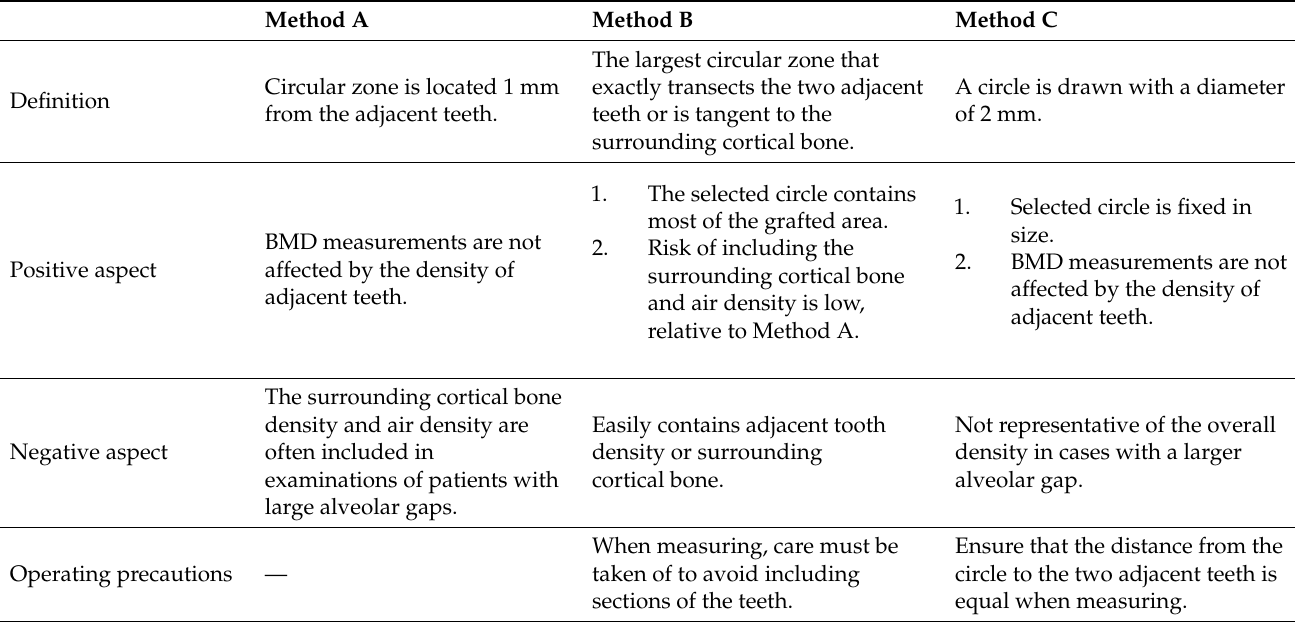
Table 4. Comparison of the positive and negative aspects from each